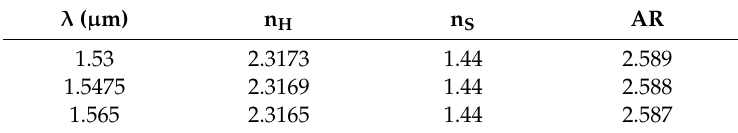
Table 2. Refractive indices and amplitudes ratio (AR) values for the operating